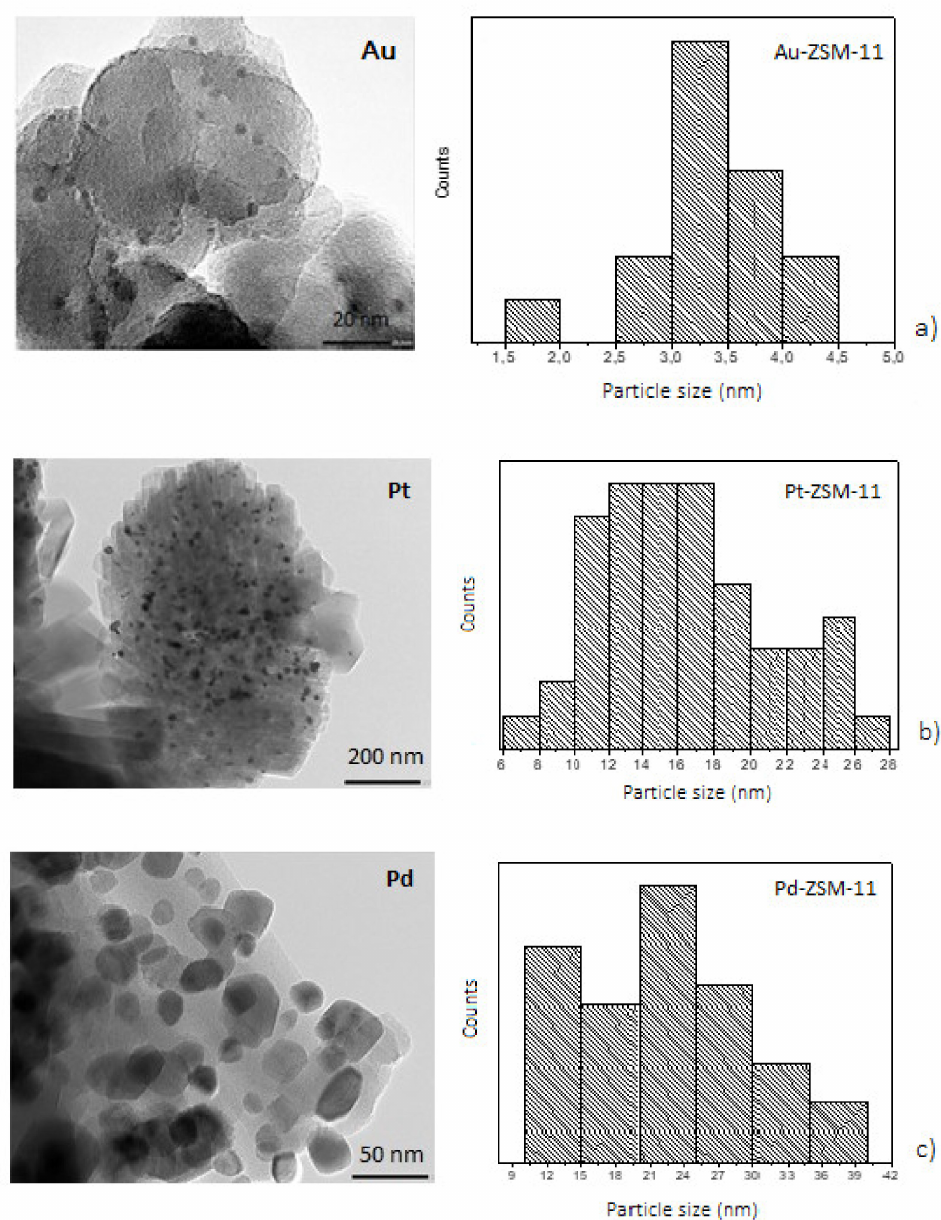
Figure 3. Transmission electron microscopy (TEM) images and particle size distribution of the monometallic catalysts; ( a ) Au- ZSM-11, ( b ) Pt-ZSM-11, ( c )